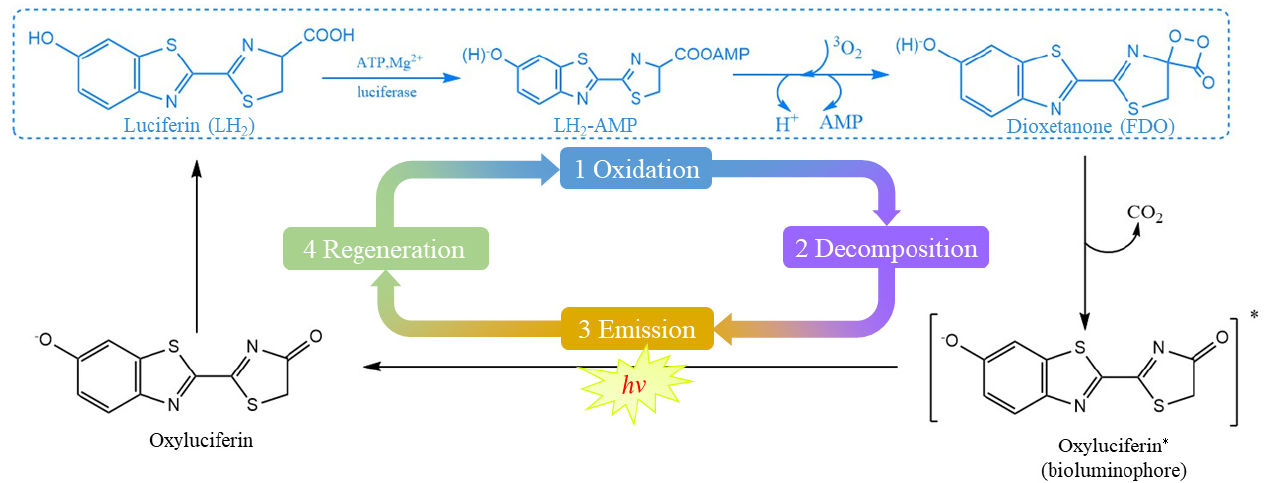
Figure 1. The four stages of a cycle of firefly bioluminescence. * indicates the excited state.